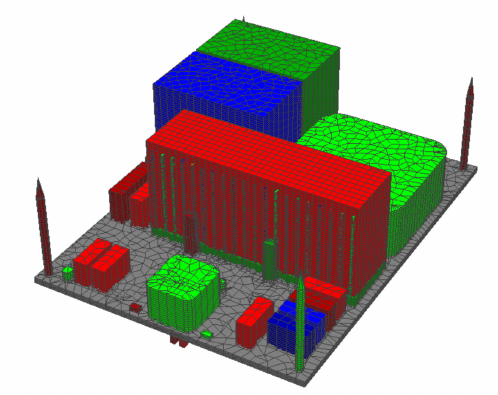
Figure 6. Generic finite element analysis (FEA) model of the PCB under